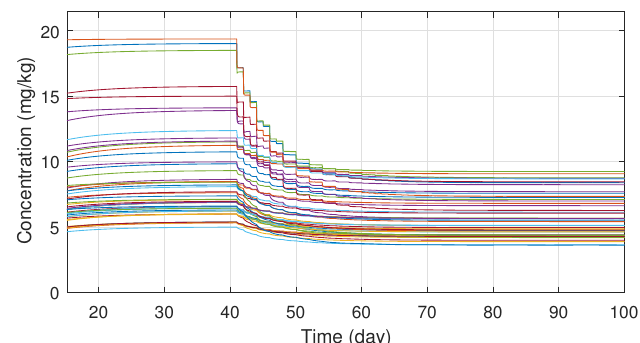
Figure 7. Administration protocols under parameter